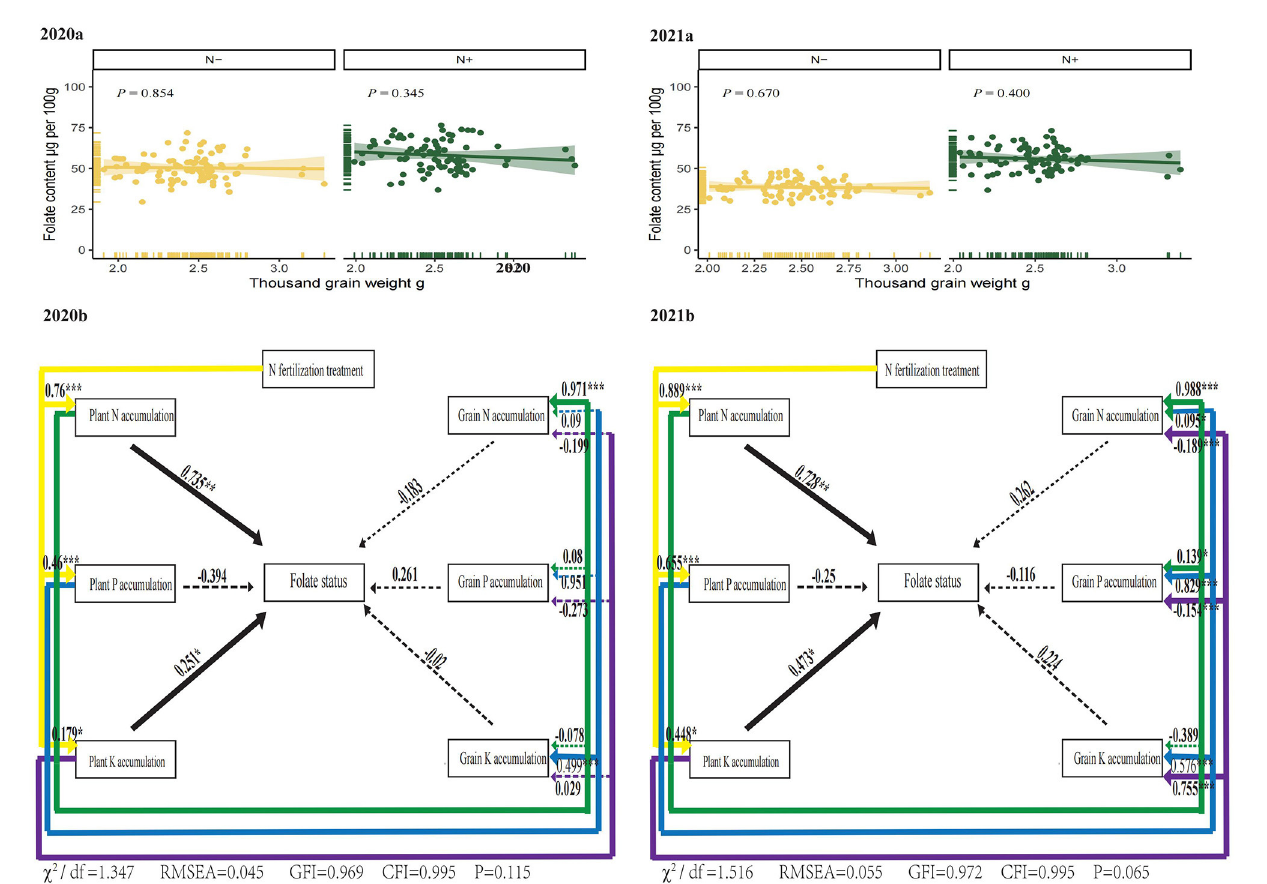
FIGURE6 Correlation of foxtail millet thousand grain weights with total folate in 2 years. Structural equation models (SEM) to evaluate the direct and indirect effects of plant nutrient accumulation, grain nutrient accumulation, above ground biomass and grain yield on folate levels in foxtail millet. N–, N deficiency; N + , N applied treatment. The goodness-of-fit index (GFI), Bentler comparative fit index (CFI), Chi-square test and root mean square error of approximation (RMSEA) indicate the goodness-of-fit of the models to the original data. * and *** indicate the standard of significance at 0.05 and 0.001 level,